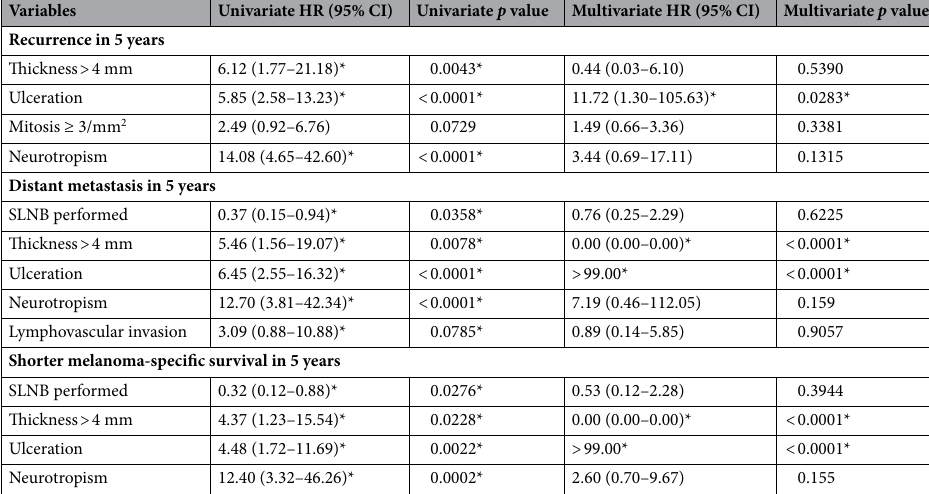
Table 5. Univariate and multivariate analyses of prognostic factors for recurrence, distant metastasis, and melanoma-specific survival in 5 years among ALM patients. ALM acral lentiginous melanoma, HR hazard ratio, CI confidence interval, SLNB sentinel lymph node biopsy. *Statistically